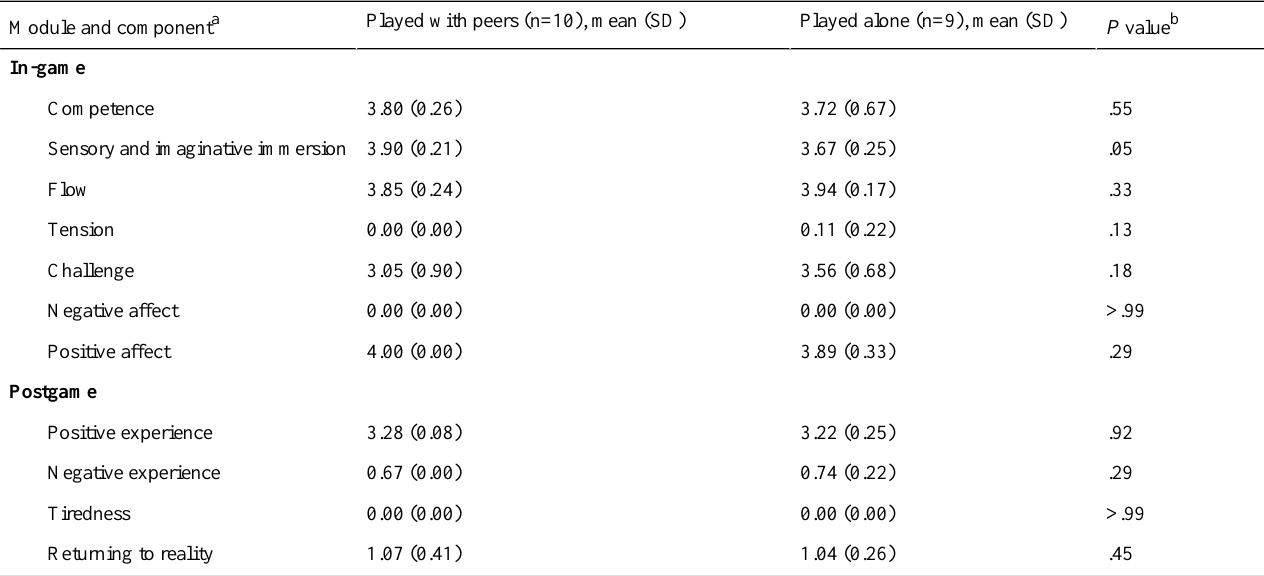
Table 2. Mean (SD) scores for the components of the Game Experience